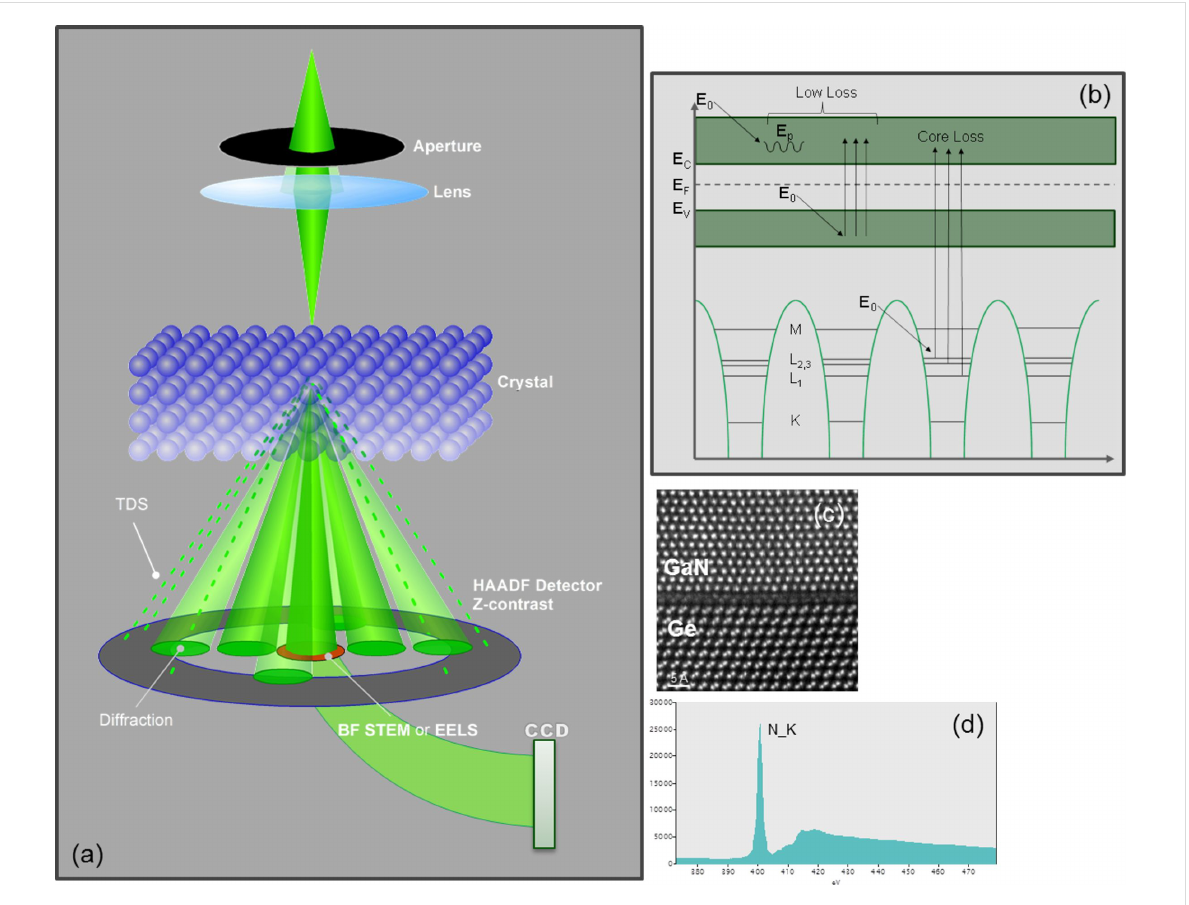
Figure 4: A schematic illustration of the principle in STEM-EELS: (a) the microscope configuration in the STEM mode; (b) the inelastic scattering processes in the TEM sample contributing to the low-loss and the core-loss EELS signals; (c) an atomic-resolution STEM-HAADF image of a GaN–Ge interface; (d) a EELS core-loss spectrum showing the N_K edge of gaseous N 2 .